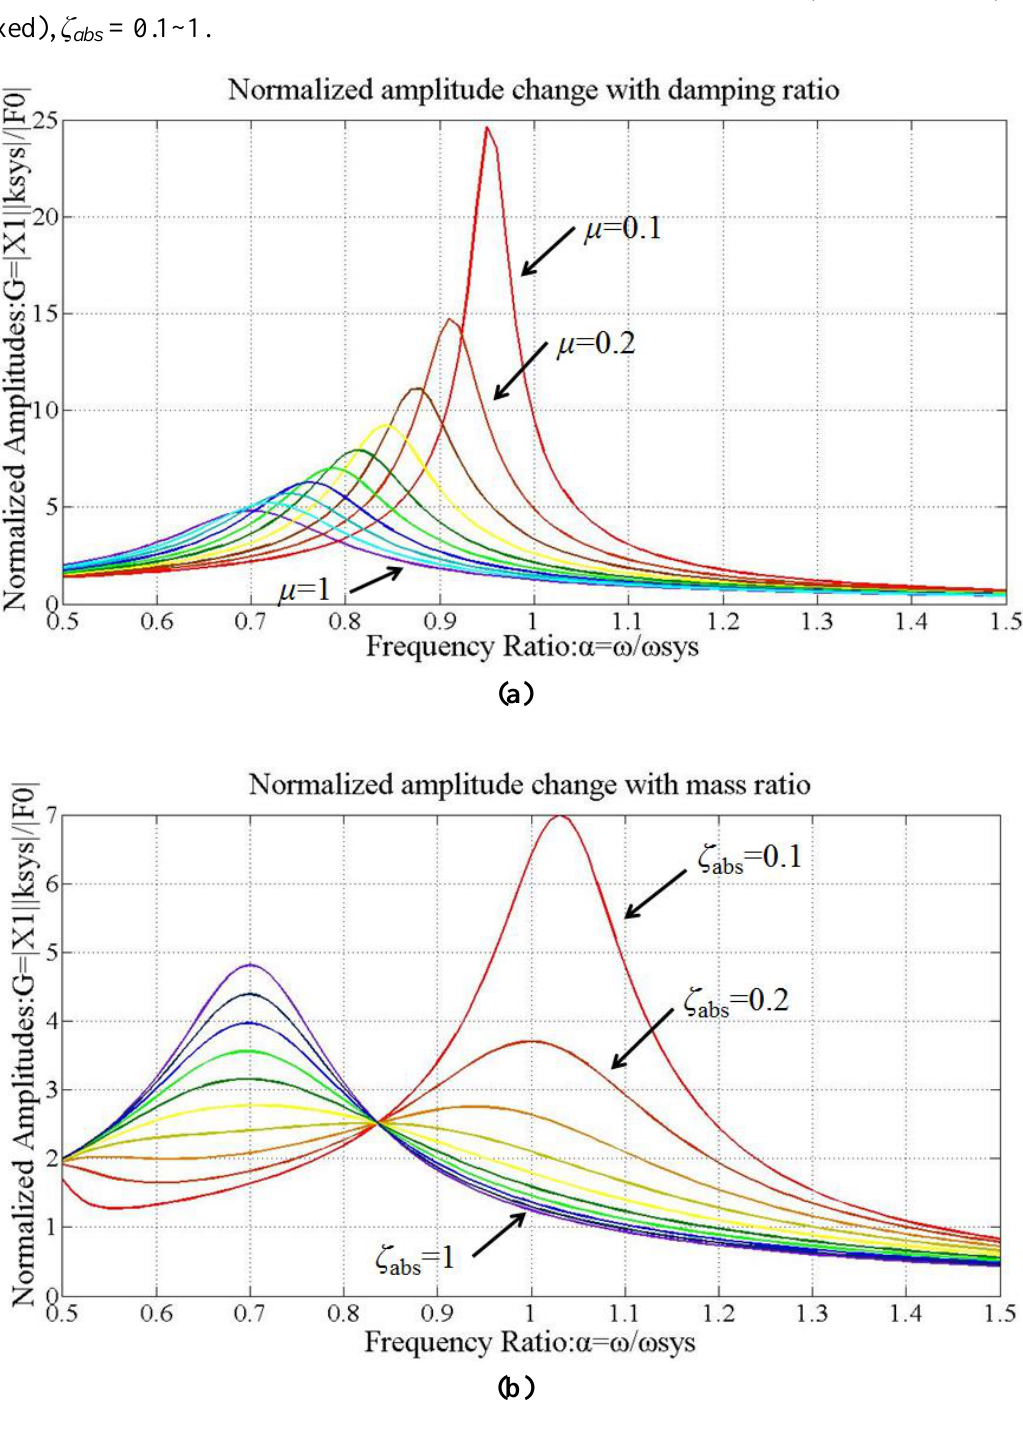
= 1 (fixed), μ = 0.1~1. (b) μ = 1 abs